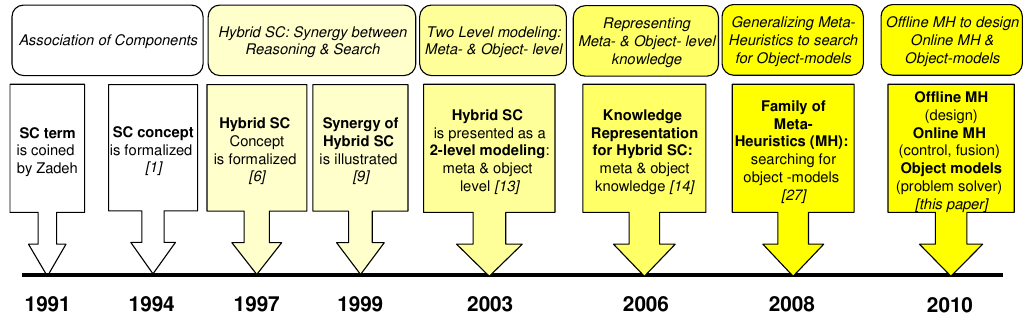
Fig. 9. Timeline depicting the author’s perception of SC